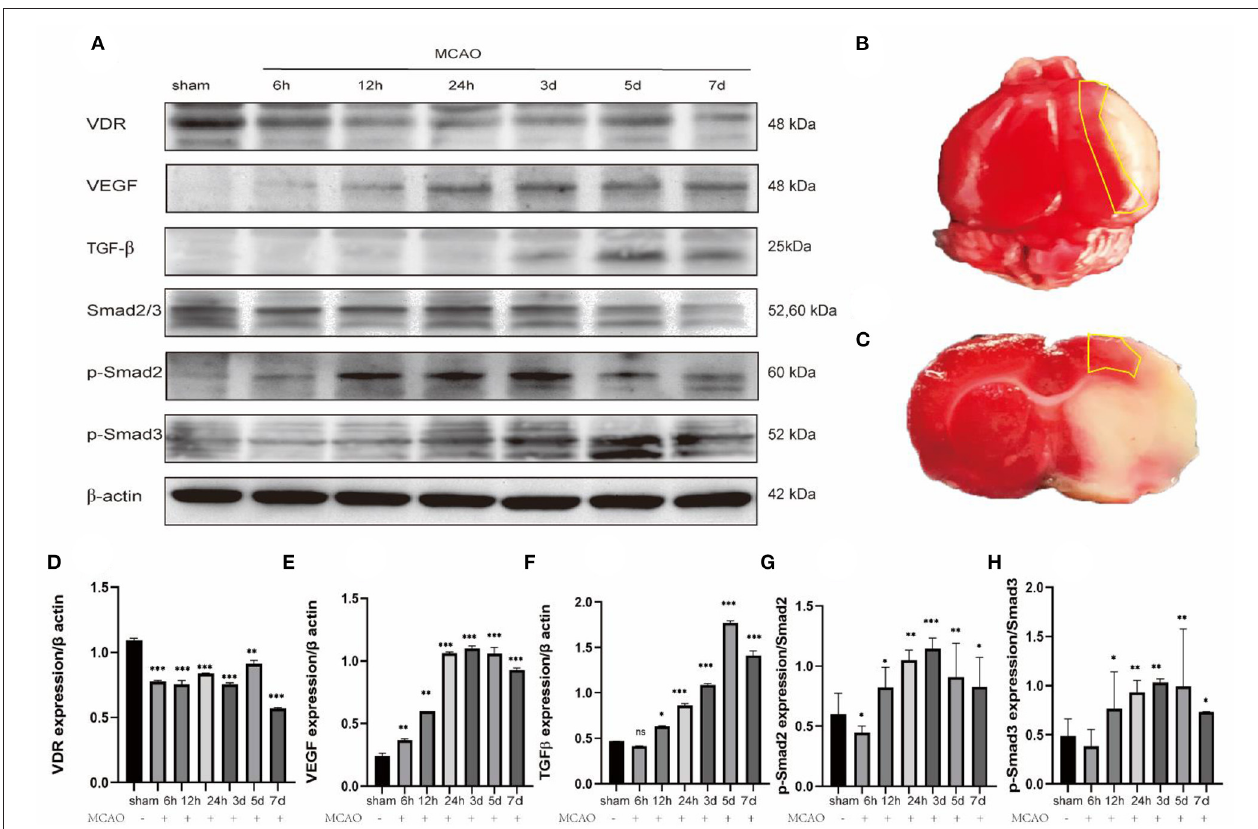
FIGURE 5 | Changes in the expression of relevant proteins at different time after ischemia reperfusion. (A,D–H) Western blots shows the expression levels of VDR, VEGF, TGF- β , Smad2/3, p-Smad2, p-Smad3 differ at different time after ischemia reperfusion in the ischemic penumbra cortex. Data were represented as Mean ± SEM, n = 3 per group. * p < 0.05, ** p < 0.005, *** p < 0.001. (B,C) The yellow box selection indicates the area of the ischemic